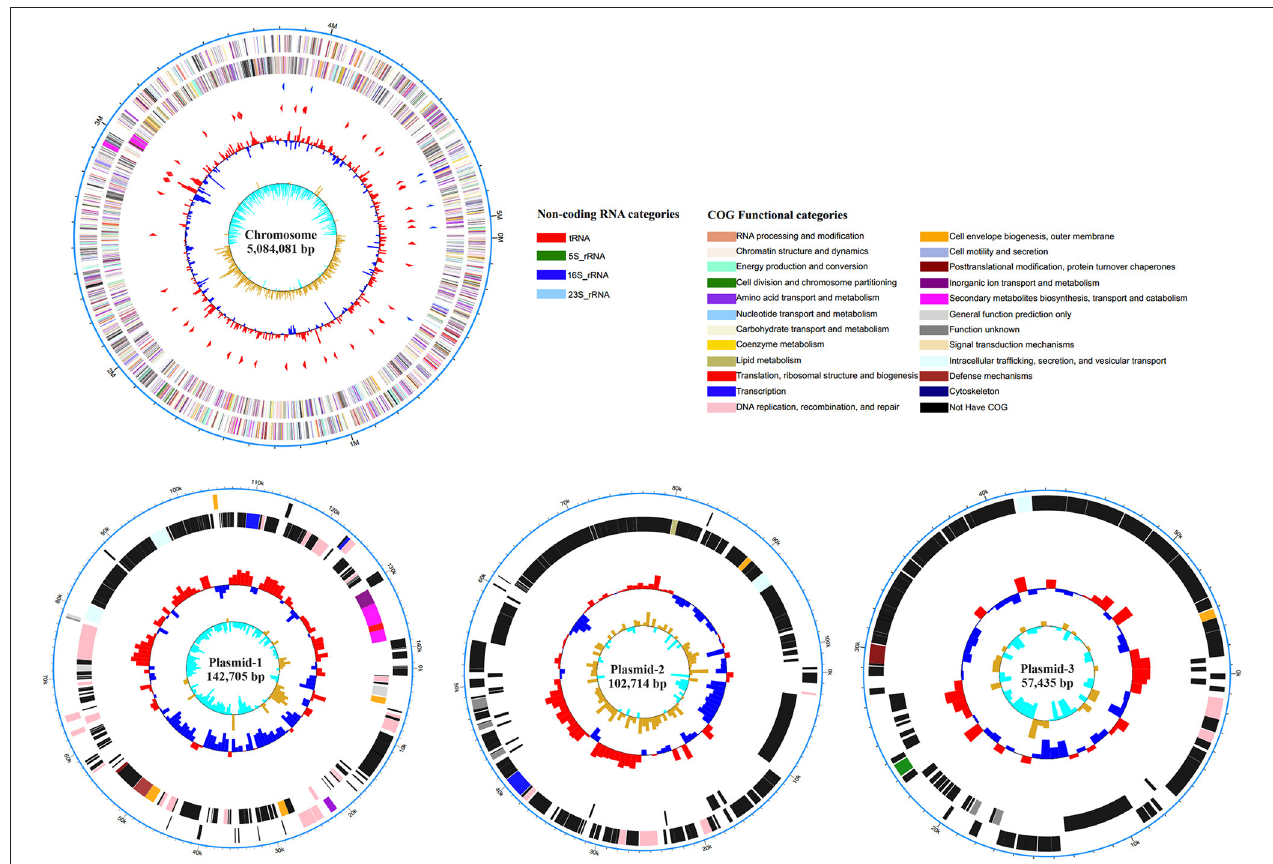
FIGURE 3 | Circular representation of the chromosome and plasmids of strain BCE049 and related annotations. Maps were established using the software Circos v0.64 (http://circos.ca/). The key information pertains to the circular diagrams (outside to inside): the outermost rings show scales of the BCE049 chromosome and plasmids, where each division is 0.5Mb and 10.0kb, respectively; the second rings show the coding sequence (CDS) on the positive chains, and the different colors indicate the functional classification of different Clusters of Orthologous Group (COGs) of the CDS; the third rings show the CDS on the negative chains, and the different colors indicate the functional classification of different COGs of the CDS; the fourth ring shows non-coding genes (rRNA, tRNA, tmRNA); the innermost ring shows GC skew [(G – C)/(G +